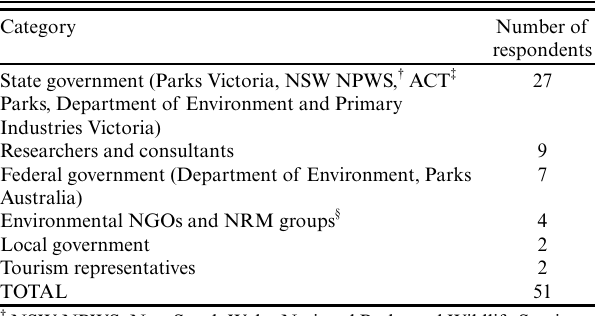
Table 1 . Individuals interviewed in each